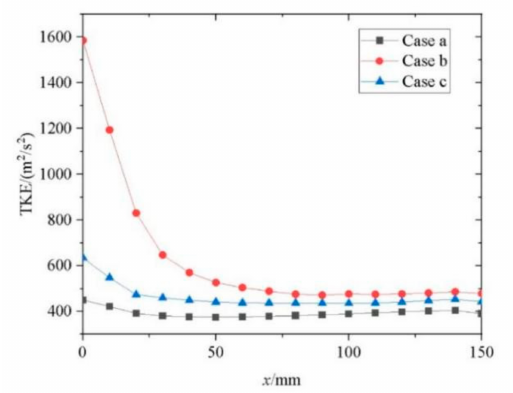
Figure 13. Curves of the average turbulent kinetic energy in sections for Case a, Case b, and Case